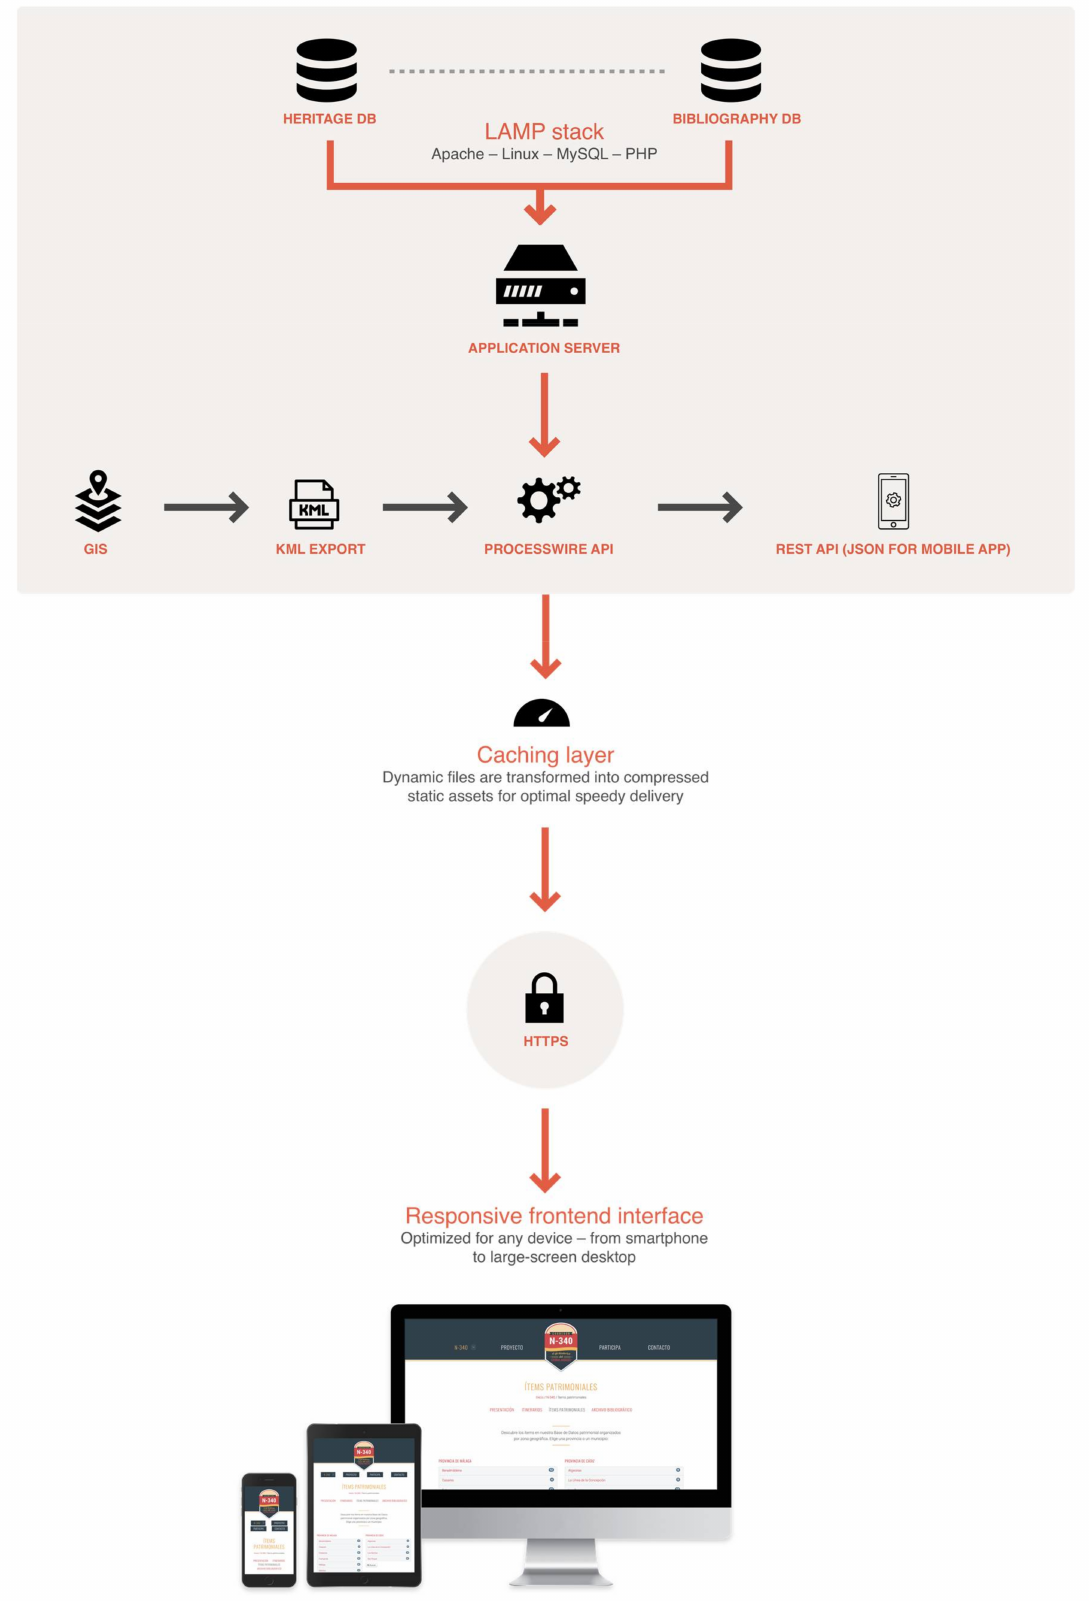
Figure 3. System